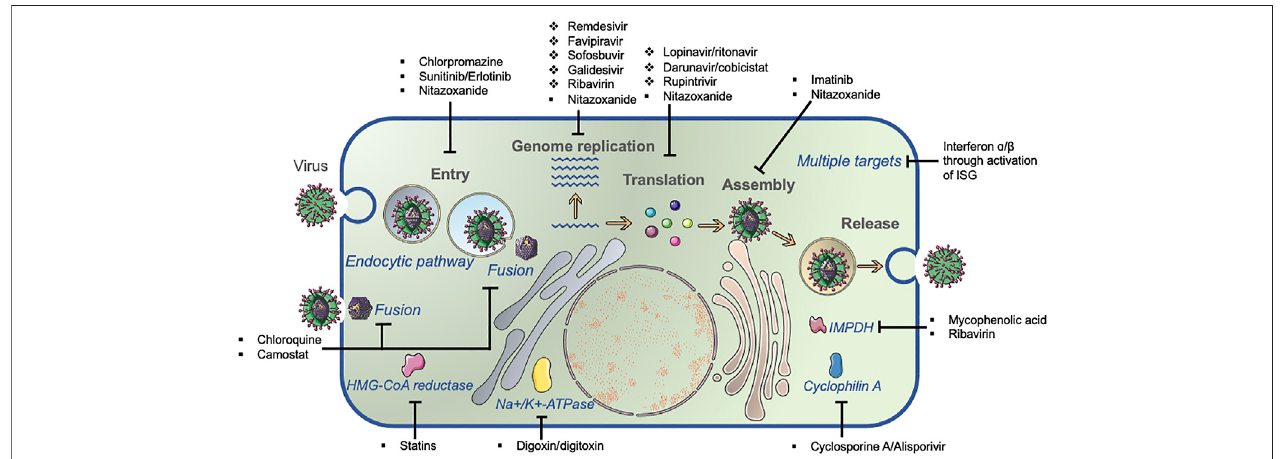
FIGURE 2 | Common viral lifecycle and broad-spectrum antiviral identi fi cation. The common viral lifecycle comprises three steps: viral entry, genome replication, andvirusassembly/release.Direct-actingantivirals(DAA, ❖ )andhost-targetingantivirals(HTA, ■ )inhibitvirusreplicationbytargetingviralproteinandhostmoleculesthat are required for virus replication,